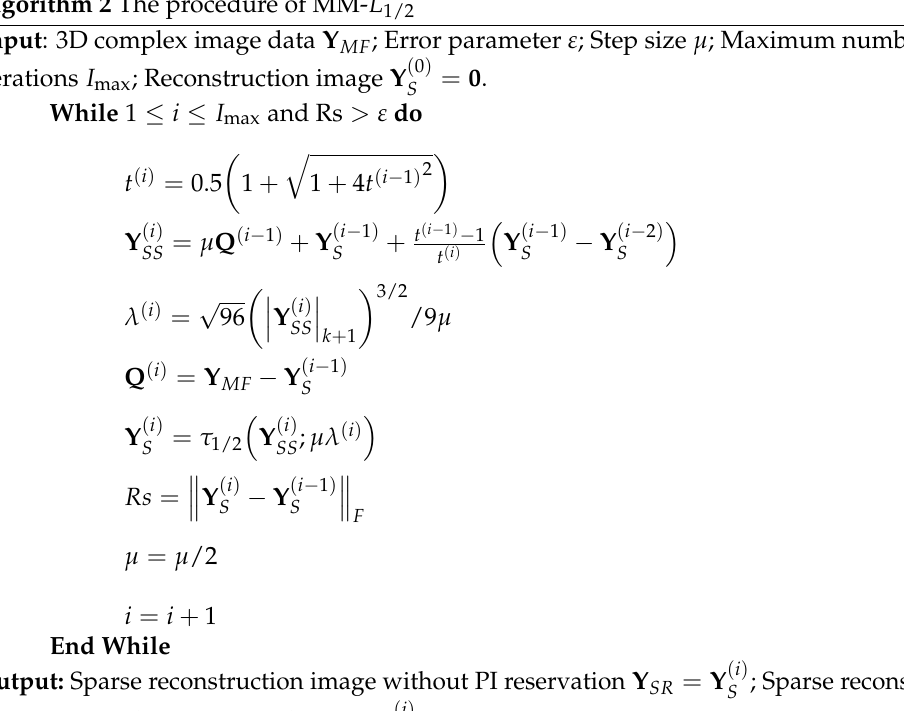
Algorithm 2 The procedure of MM- L